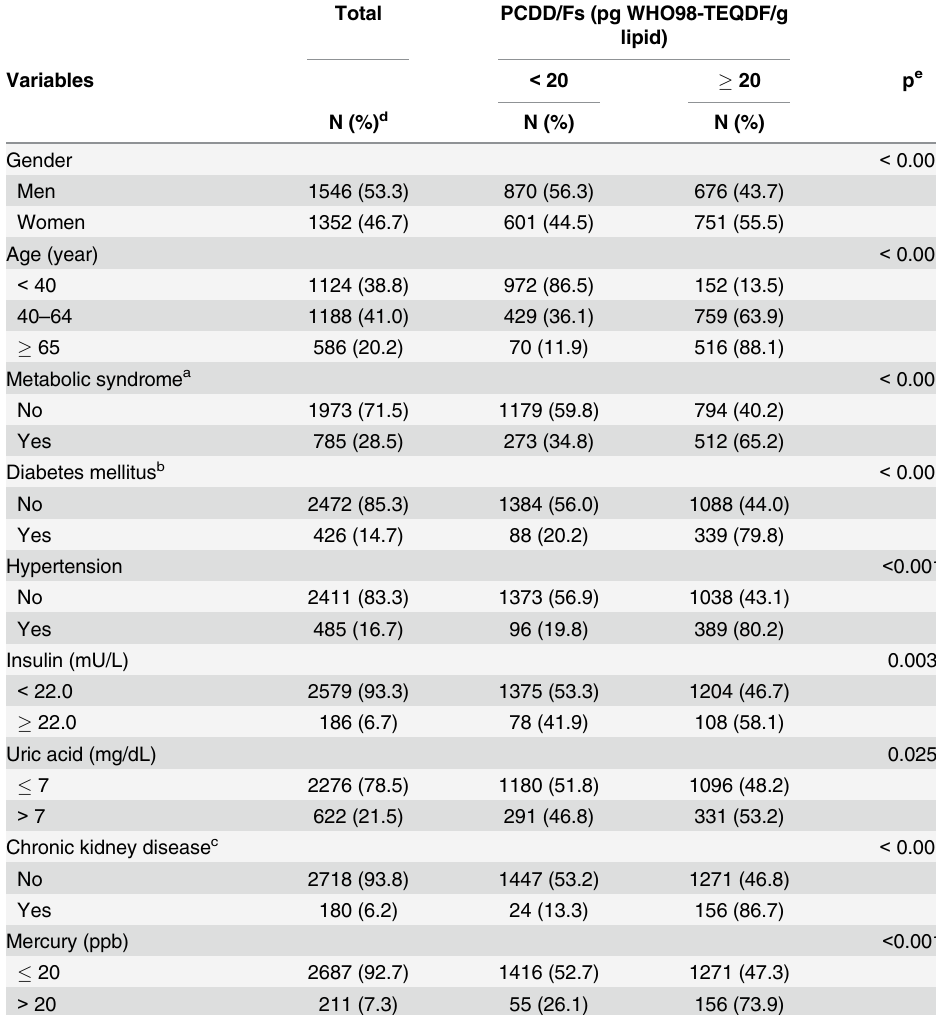
Table 1. Distributions (number and percentage) of variables in the participants and comparisons of variables between participants with and without a high level of dioxin. Total PCDD/Fs (pg WHO98-TEQDF/g lipid) Variables < 20 (cid:1) 20 p